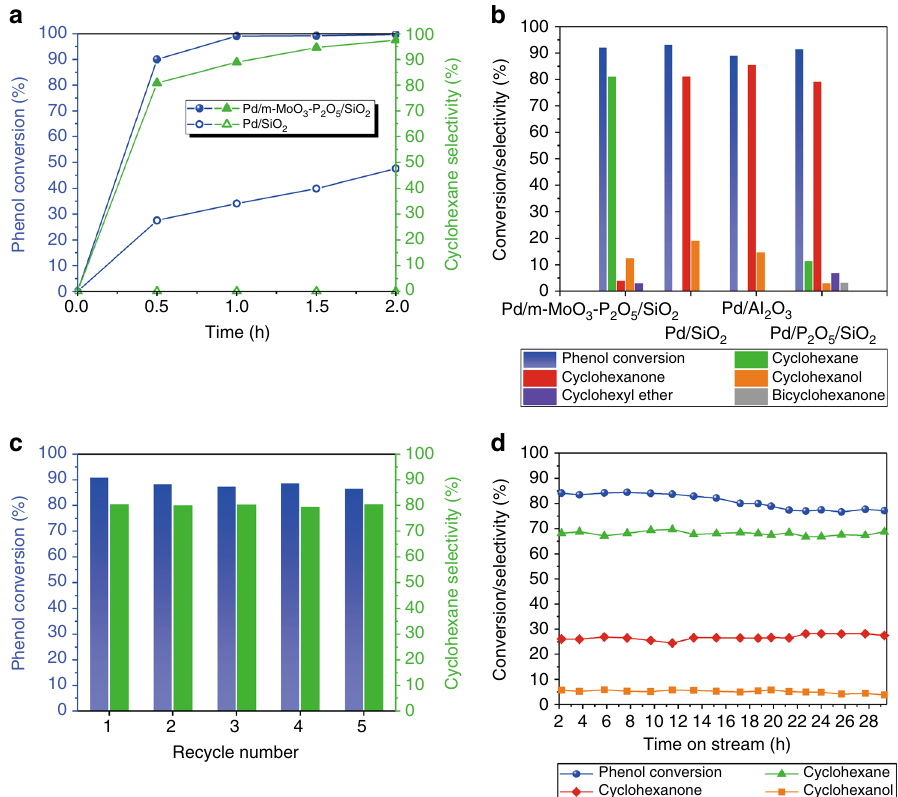
Fig. 3 Catalytic performance on HDO of phenol. a Time dependence of the phenol conversion and cyclohexanol selectivity using Pd/m – MoO 3 – P 2 O 5 /SiO 2 and Pd/SiO 2 catalysts in batch reactions. Reaction conditions: phenol (0.195 mmol), catalyst (including 0.00045 mmol Pd), decalin (7 mL), 383 K, 1 MPa H 2 ; reaction mixture stirred at 800 rpm. b Comparison of product selectivity of different catalysts at identical conversion level at 383 K, 1 Mpa H 2 in batch reaction. Reaction conditions: phenol (0.195 mmol), catalyst (including 0.00045 mmol Pd), decalin (7 mL), reaction mixture stirred at 800 rpm. c Stability test of Pd/m – MoO 3 – P 2 O 5 /SiO 2 in batch reaction. Reaction conditions: 383 K, 1 Mpa H 2 , 0.5 h. d Long-term stability test on the Pd/m – MoO 3 – P 2 O 5 /SiO 2